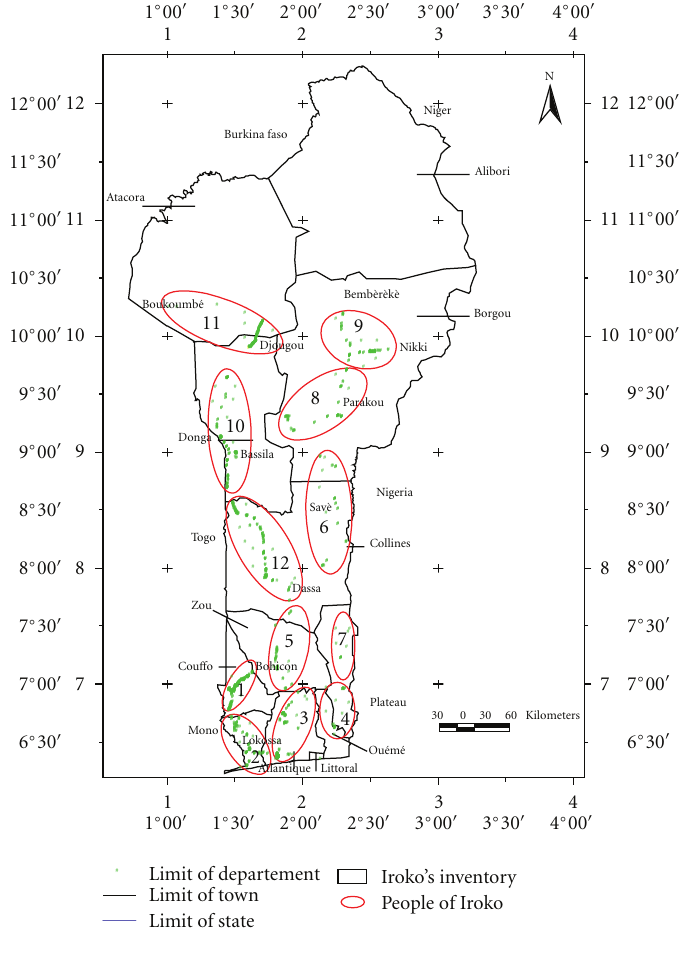
Figure 1: Milicia excelsa populations and their geographical location in Benin. Aplahoue (1), Lokossa (2), Niaouli (3), Sakete (4), Bohicon (5), Save (6), Ketou (7), Tamarou (8), Biro (9), Bassila (10), Djougou (11), and Bante (12).